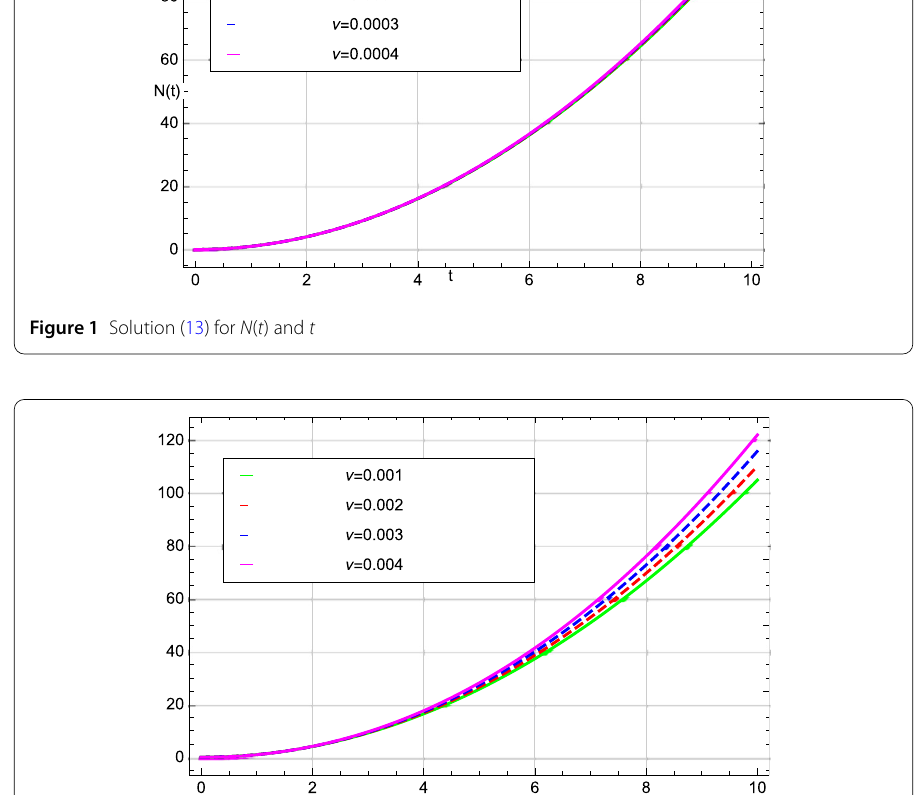
Figure 2 Solution (13) for N ( t ) and